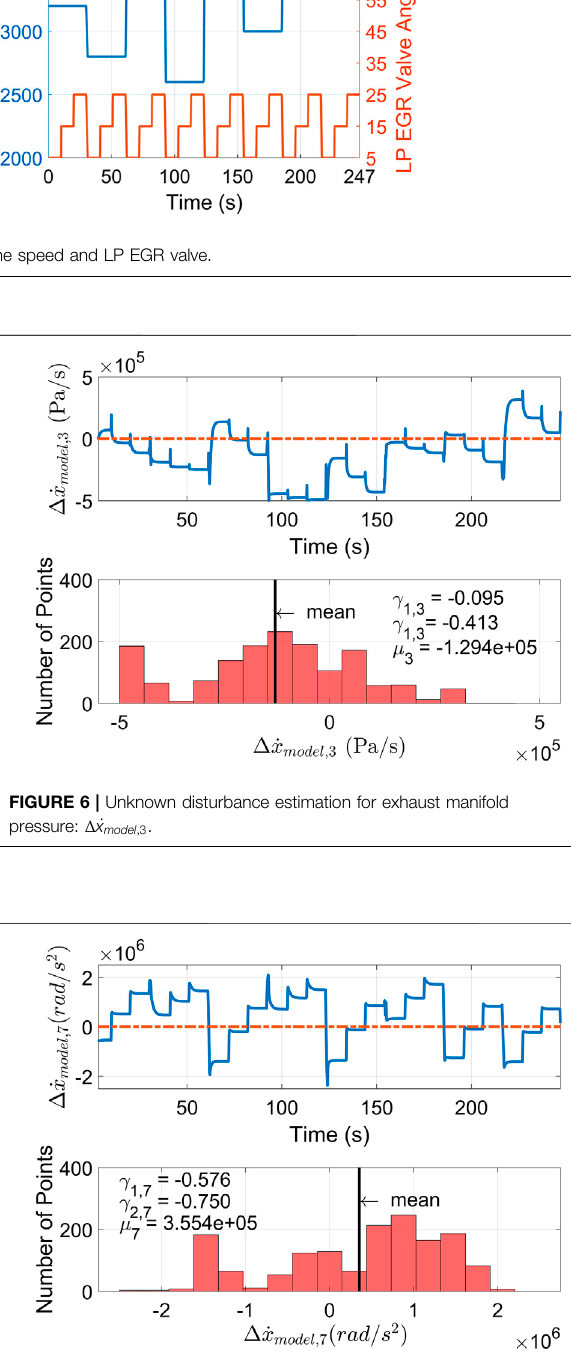
FIGURE 7 | Unknown disturbance estimation for turbocharger speed: Δ _ x model , 7